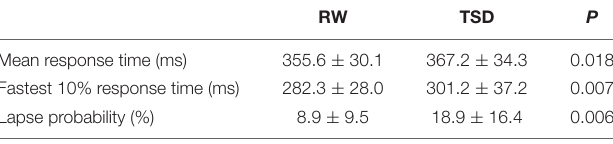
TABLE 1 | Comparison of PVT performance between RW and TSD